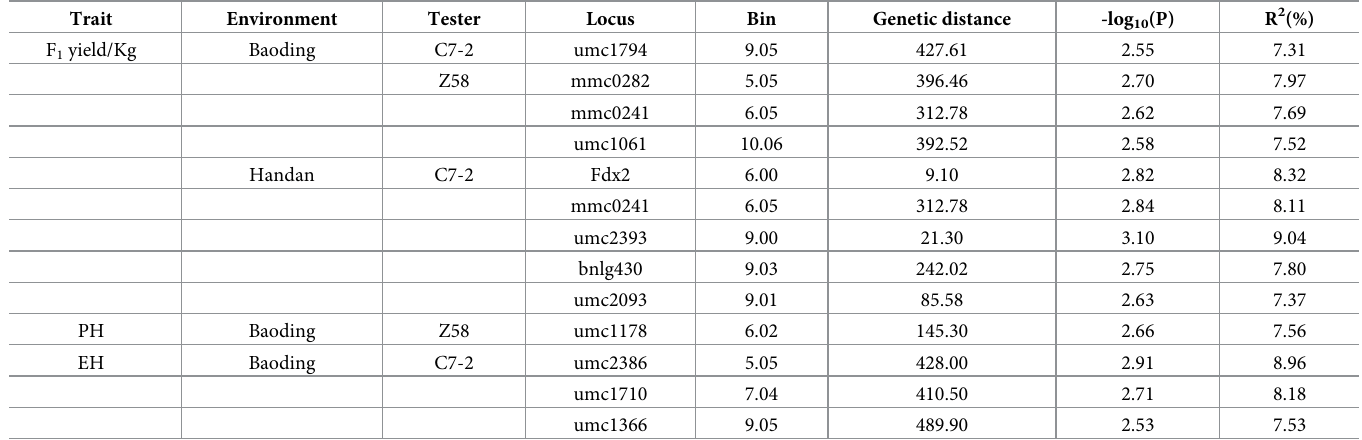
Table 5. Marker loci associated with GY, PH, EH. Trait